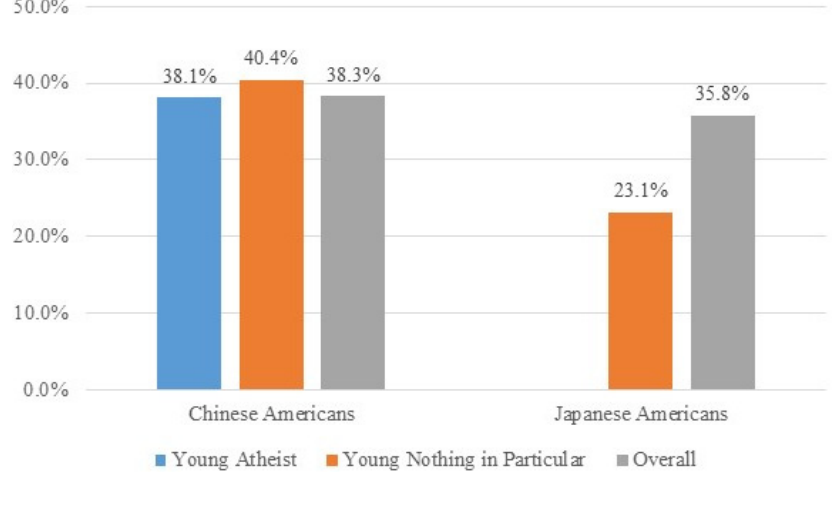
Figure 19. Moderate political